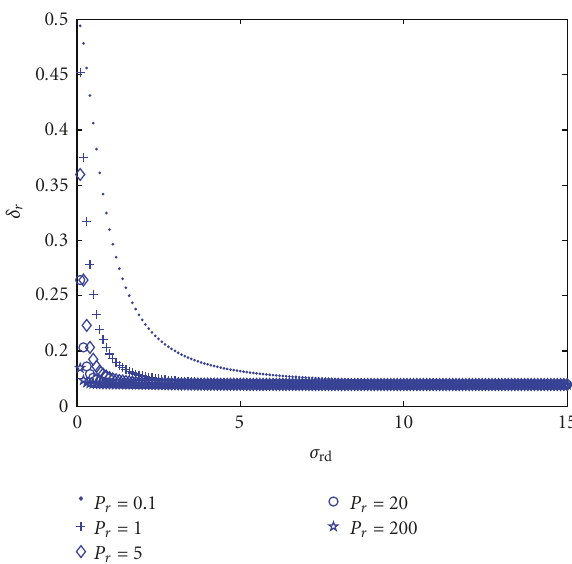
Figure 4: δ r versus σ rd for di ff erent values of P r when m = 50.